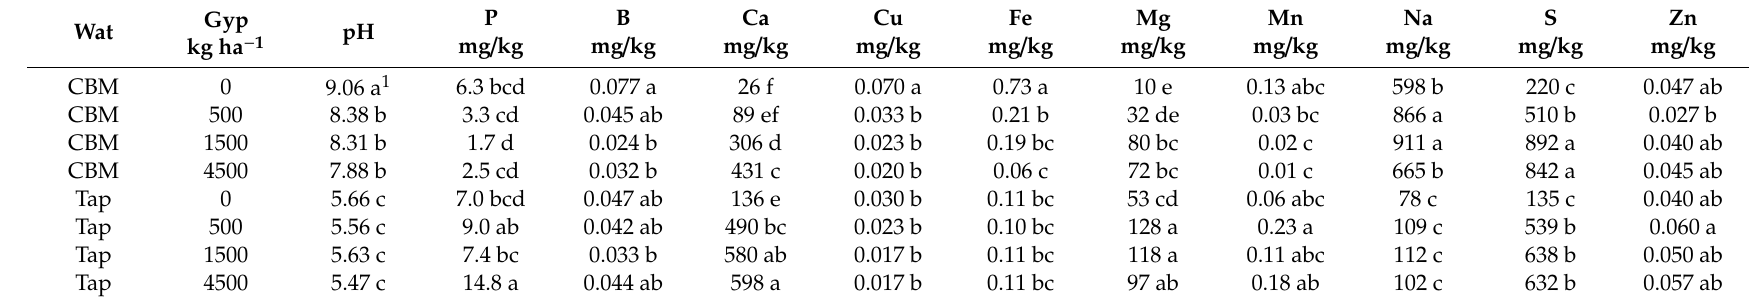
Table 7. Mean growth medium pH and available nutrients [phosphorus (P), boron (B), calcium (Ca), copper (Cu), iron (Fe), and magnesium (Mg)] obtained from the eight combinations of water (Wat: coal-bed methane and tap) and gypsum (Gyp) applications in the lemongrass